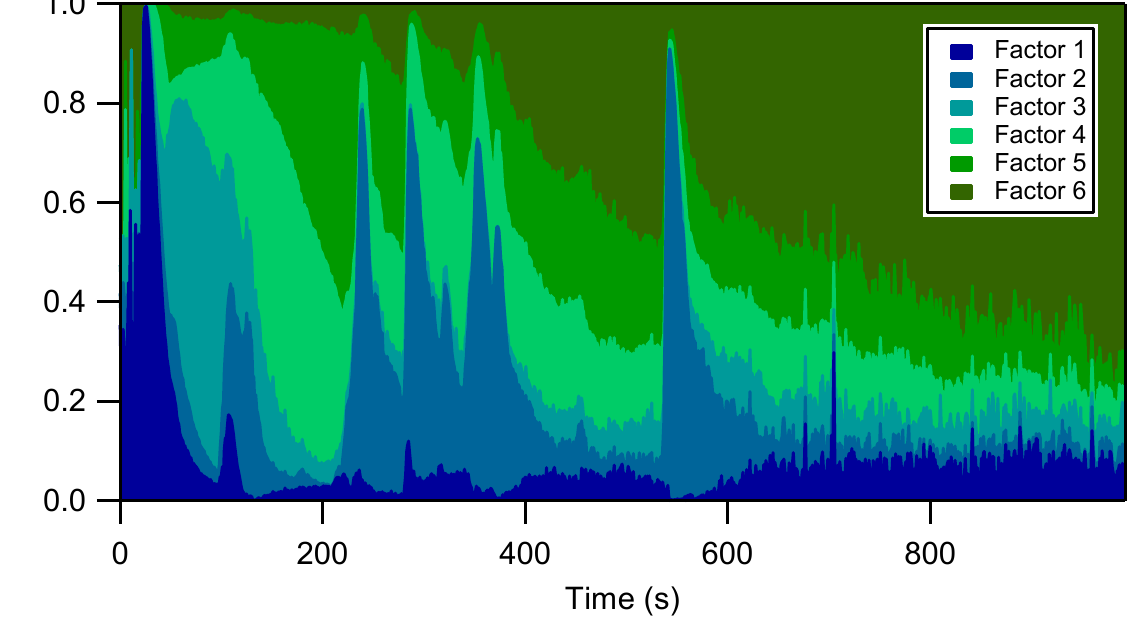
Figure 3. Temporal evolution of the PMF factor concentration ratios (ppm/ppm) during the GDI cold urban cycle.